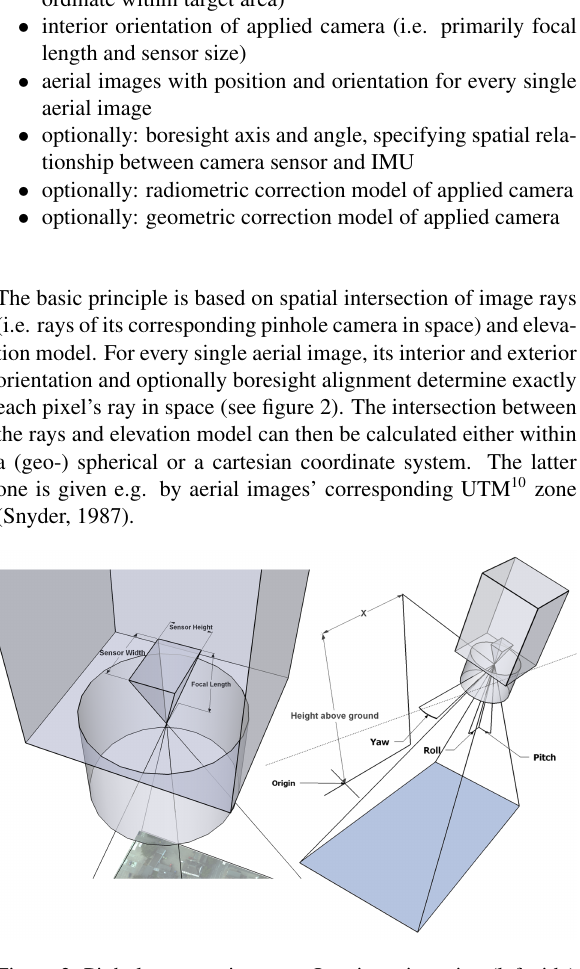
Figure 2. Pinhole camera in space: Interior orientation (left side) and exterior orientation (right side) define rays of camera sensor.